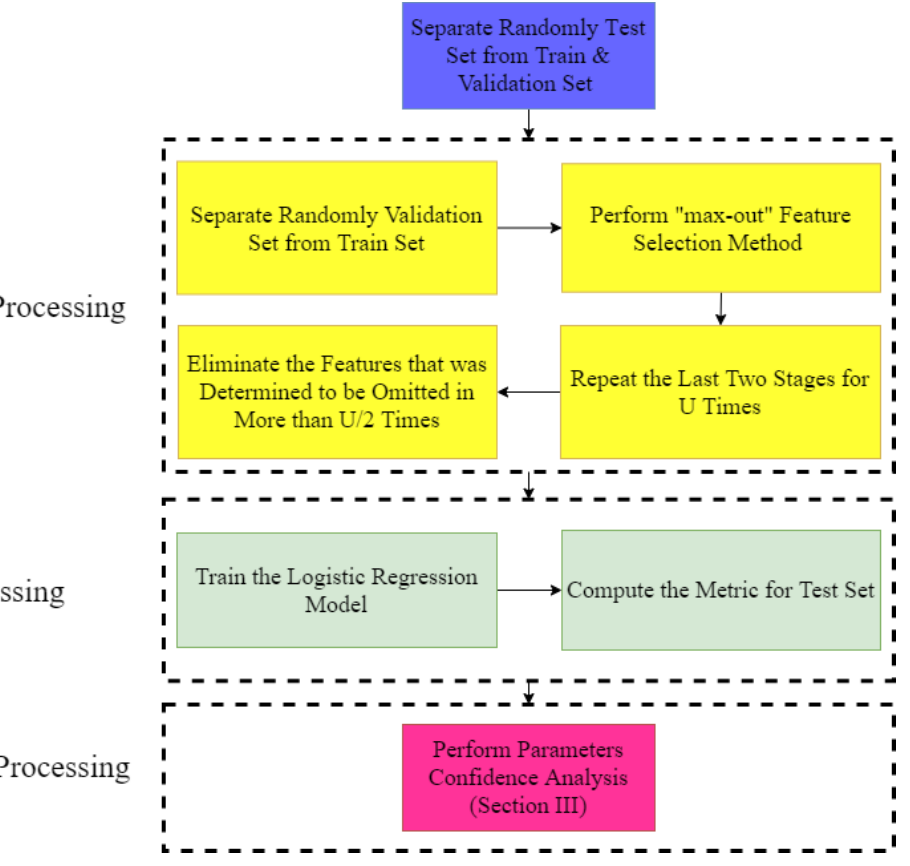
Figure 1. The general structure of the proposed attrition prediction framework.